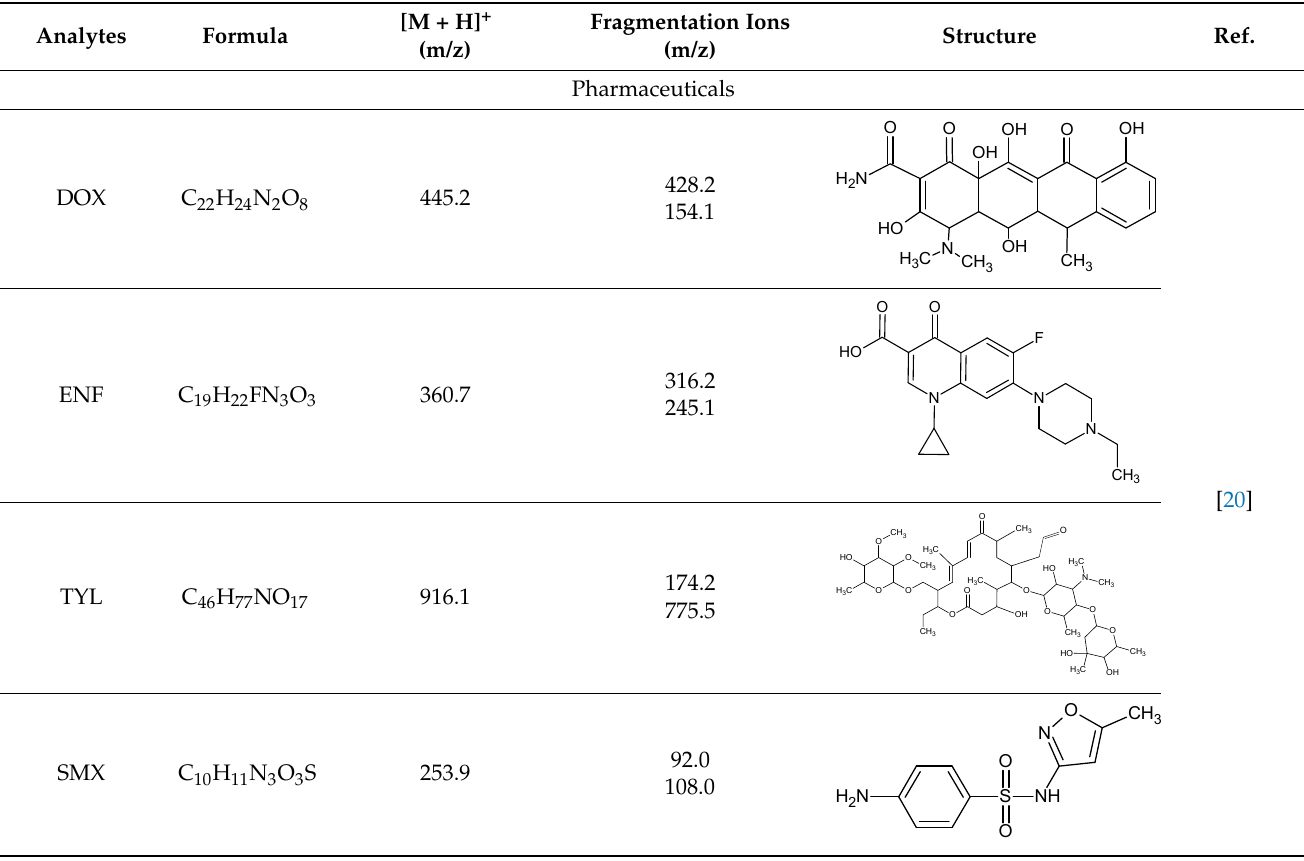
Molecules 2022 , 27 , x FOR PEER REVIEW